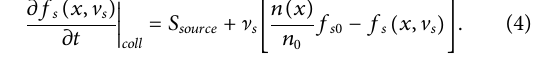
FIGURE 1 Schematic of the program